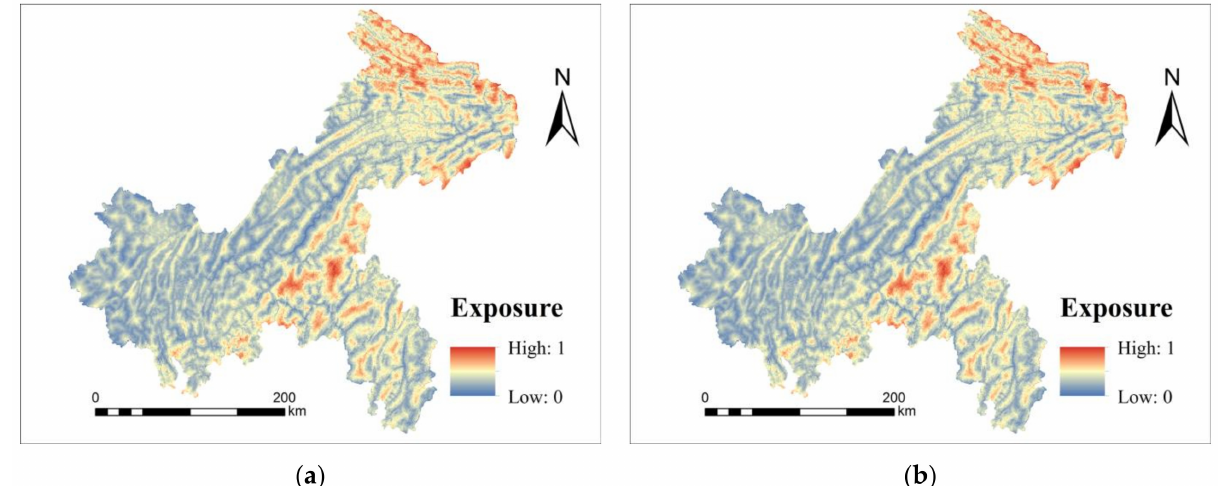
Figure 6. Spatial distribution map of flood exposure: ( a ) AHP, ( b )